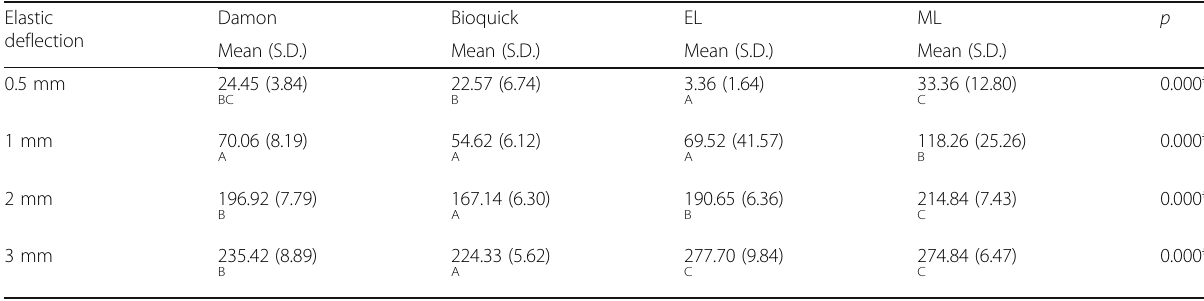
Table 3 Mean (in cN) and standard deviation (SD) of 0.014-in. conventional NiTi wires in the bracket systems ( n = 10) Elastic Damon Bioquick deflection